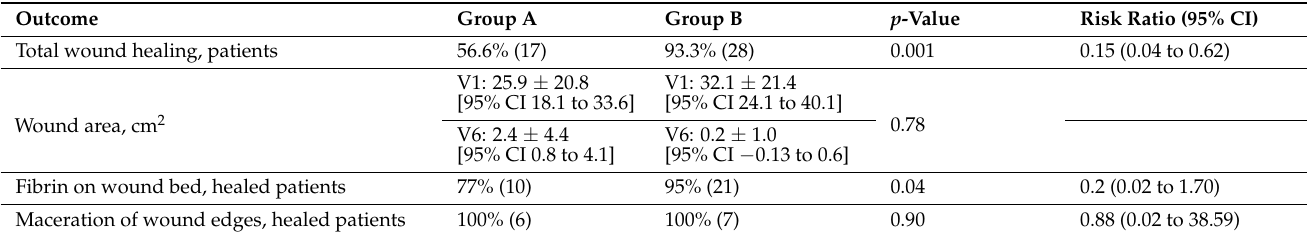
Table 4. Treatment and outcomes.